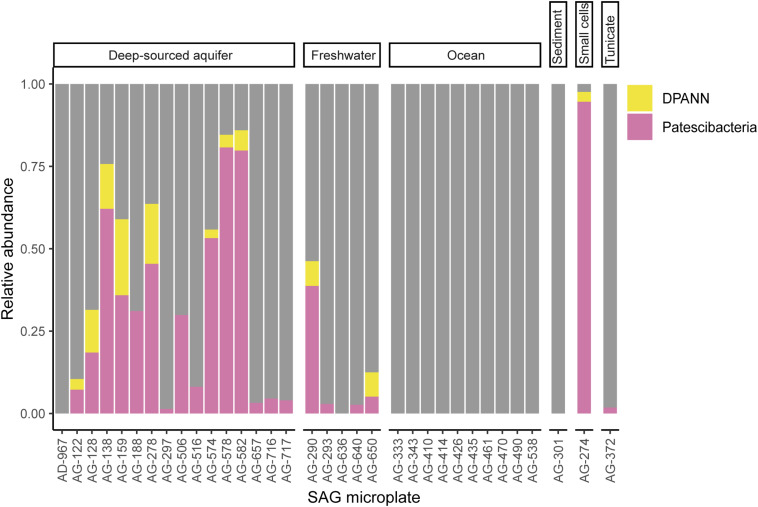
Relative abundance of Patescibacteria and DPANN in randomized SAG sets from 34 geographically diverse field samples. To avoid potential biases of the deeper sequencing of selected SAGs, only LoCoS results were used in this analysis. SAG microplate identifiers can be cross-referenced with specific SAGs and geographic sites in Supplementary Table S1. The AG-274 SAG microplate was generated from small cells from a water-filled rock fracture at 1,340 m depth below surface in the Beatrix gold mine in South Africa.